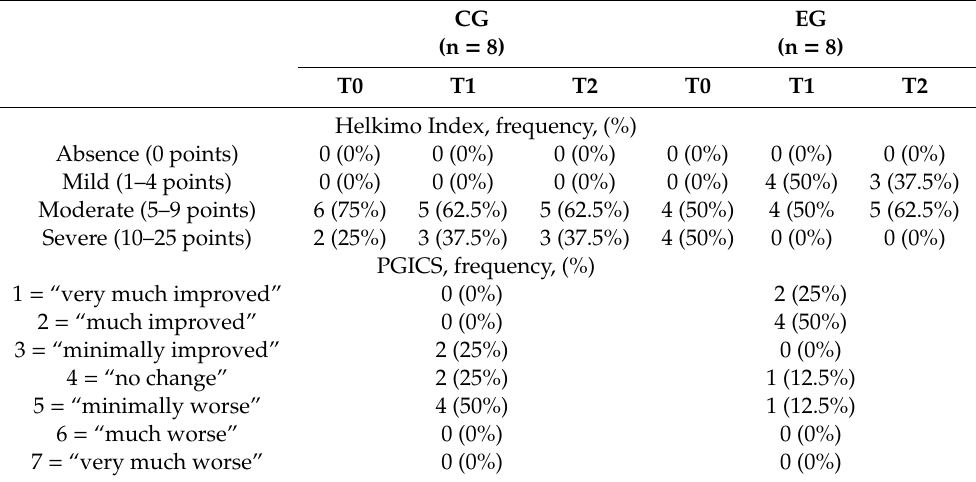
Table 4. Helkimo Index and Patient Global Impression of Change